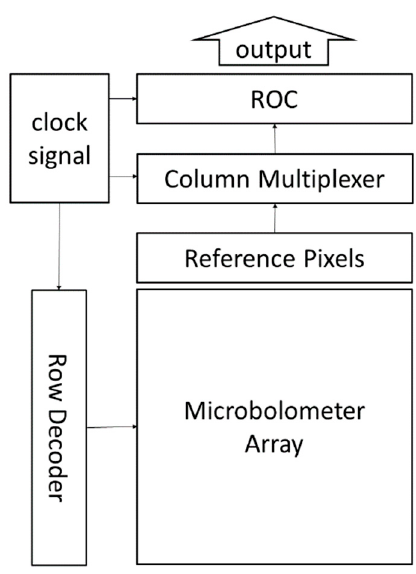
Figure 7. The block schematics of a read-out integrated circuit